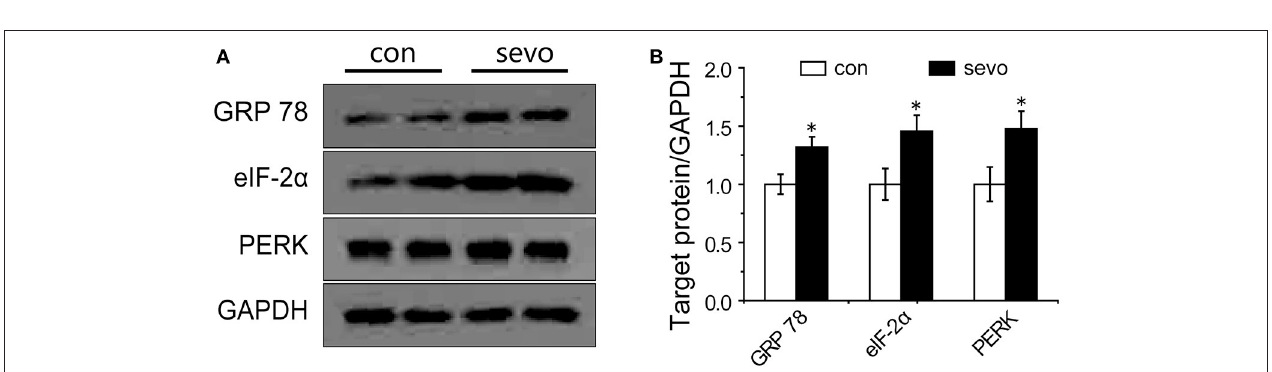
FIGURE 4 | Repeated sevoflurane exposure decreased the expression of GluR1, PSD95, and CREB. (A) Representative samples showing the hippocampal expression levels of GluR1, PSD95, and CREB in the control group and the sevoflurane group. (B) Densitometric analysis of GluR1, PSD95, and CREB. N = 4–6 times for each protein. Unpaired t -tests; * p < 0.05 vs. control. Data are presented as the means ± SEM.